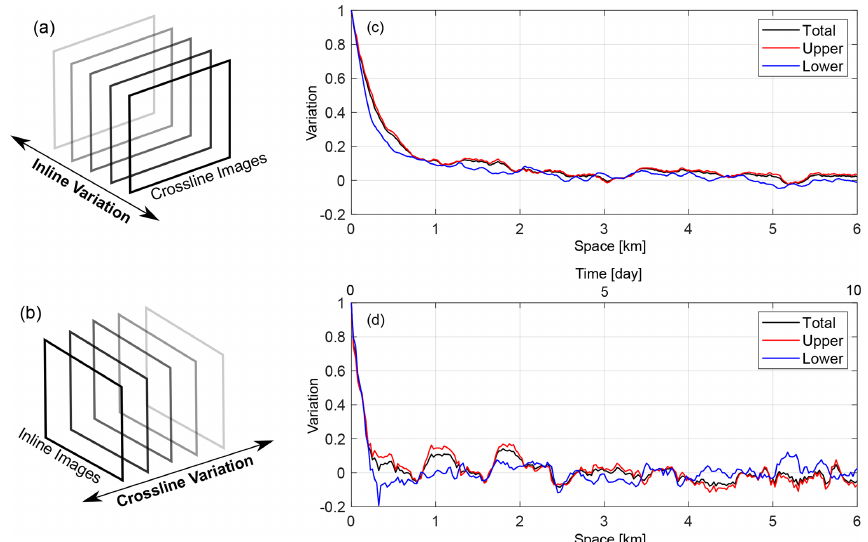
Figure 9. Inline and crossline variations from our seismic volume. Illustrations of (a) deriving inline variation from crossline image series and (b) deriving crossline variation from inline image series. Results of (c) inline variation and (d) crossline variation. The red, blue, and black curves are variations for the upper (250–500m), lower (500–750m), and total (250–750m) water column, respectively. The crossline variation is calculated within the linear acquisition period (inline 1900–2140; see Fig. 4). The time and space scales in (d) follow the linear acquisition period, which spans 6km in space or 10d in time (yielding a ratio of 0.6km/d). The inline variation is limited to 6km for easy comparison with the